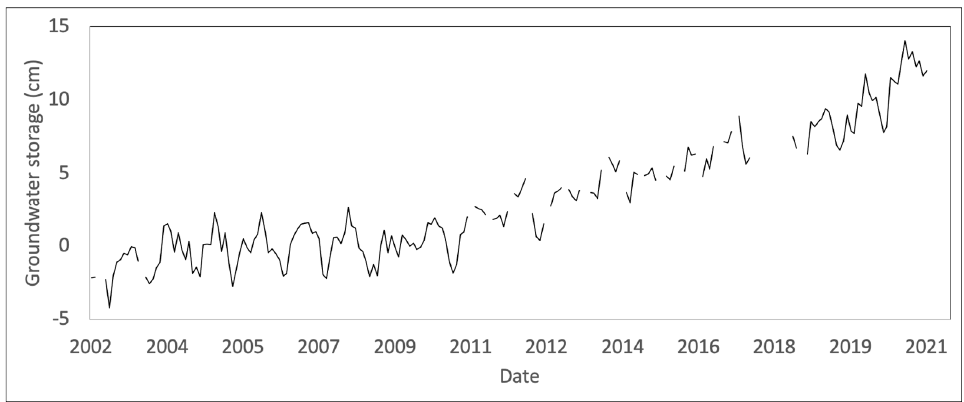
Figure 5. Original groundwater storage data from GRACE in the Iullemeden basin.